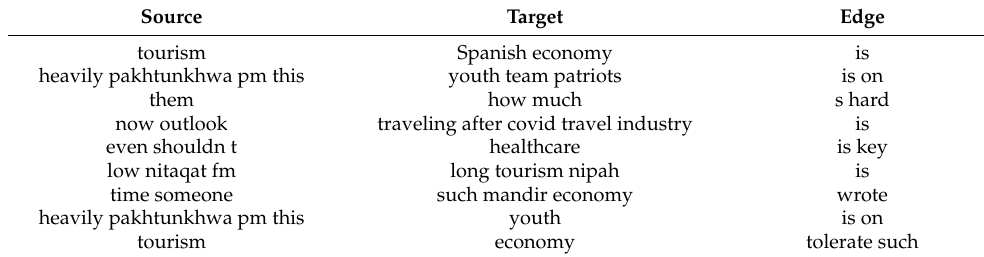
Table 8. Cluster wise Entity Relation